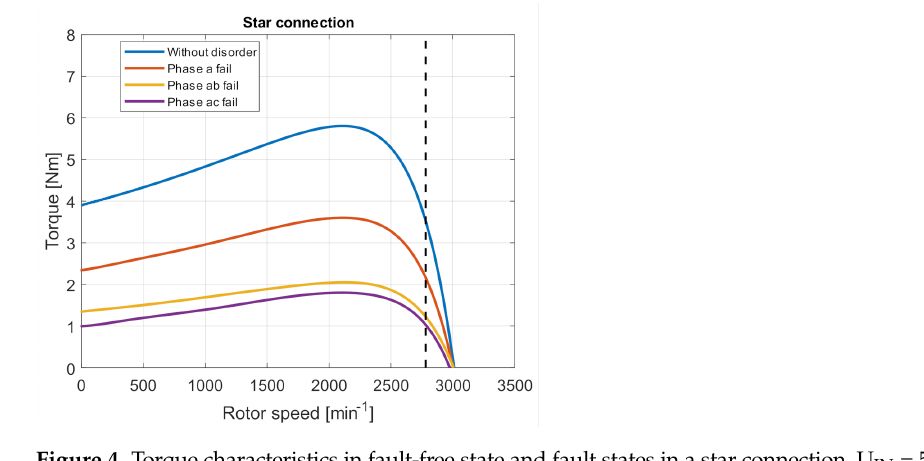
Figure 4. Torque characteristics in fault-free state and fault states in a star connection, U IN = 5 × 230 V, 50 Hz.